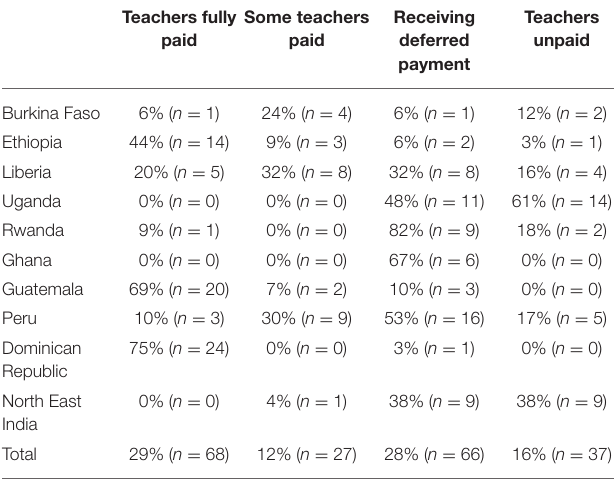
TABLE 4 | Teacher payment status ( n = 232).